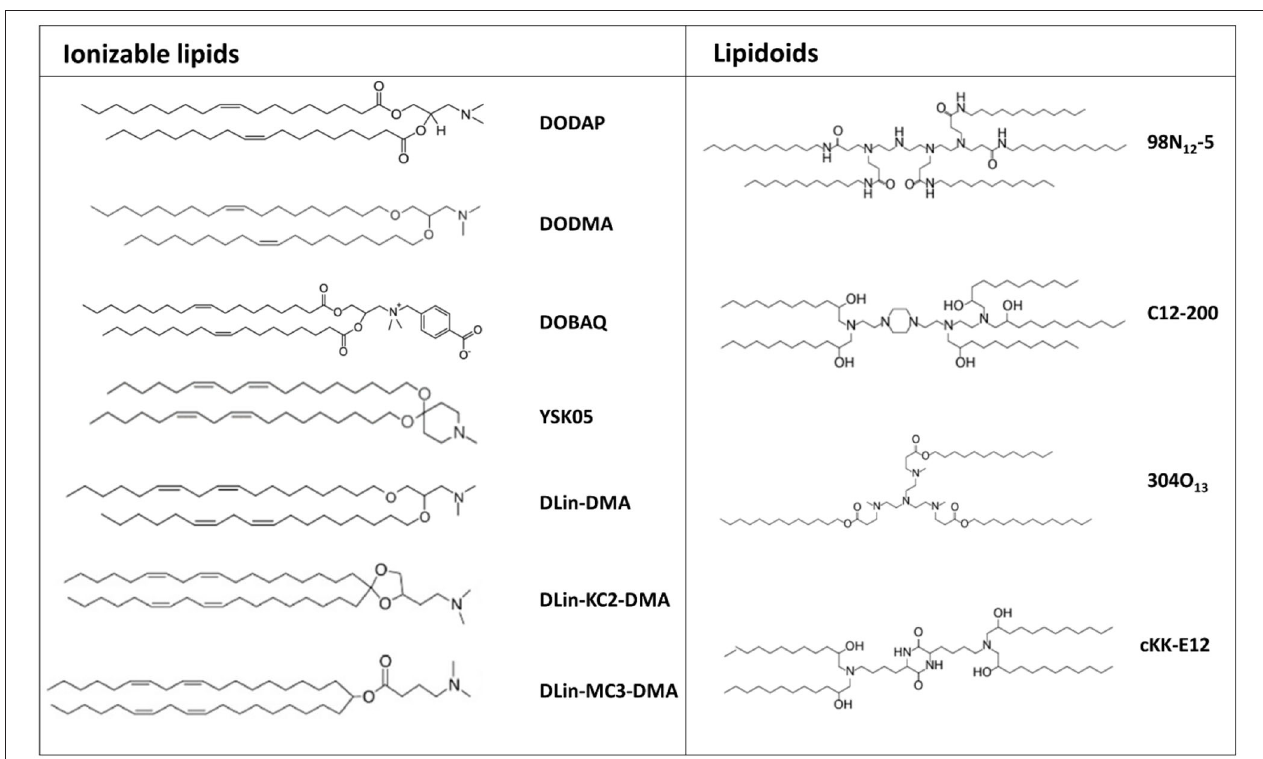
FIGURE 3 | Chemical structure of the most common ionizable lipids and lipidoids used for mRNA